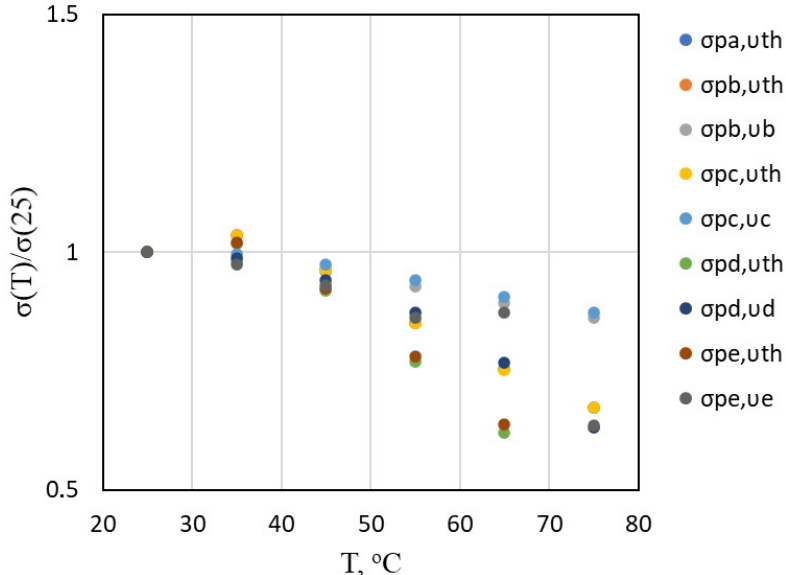
Figure 18. Dependency of cavitation number from temperature in characteristic points. Cylindric nozzle (from our CFD results).